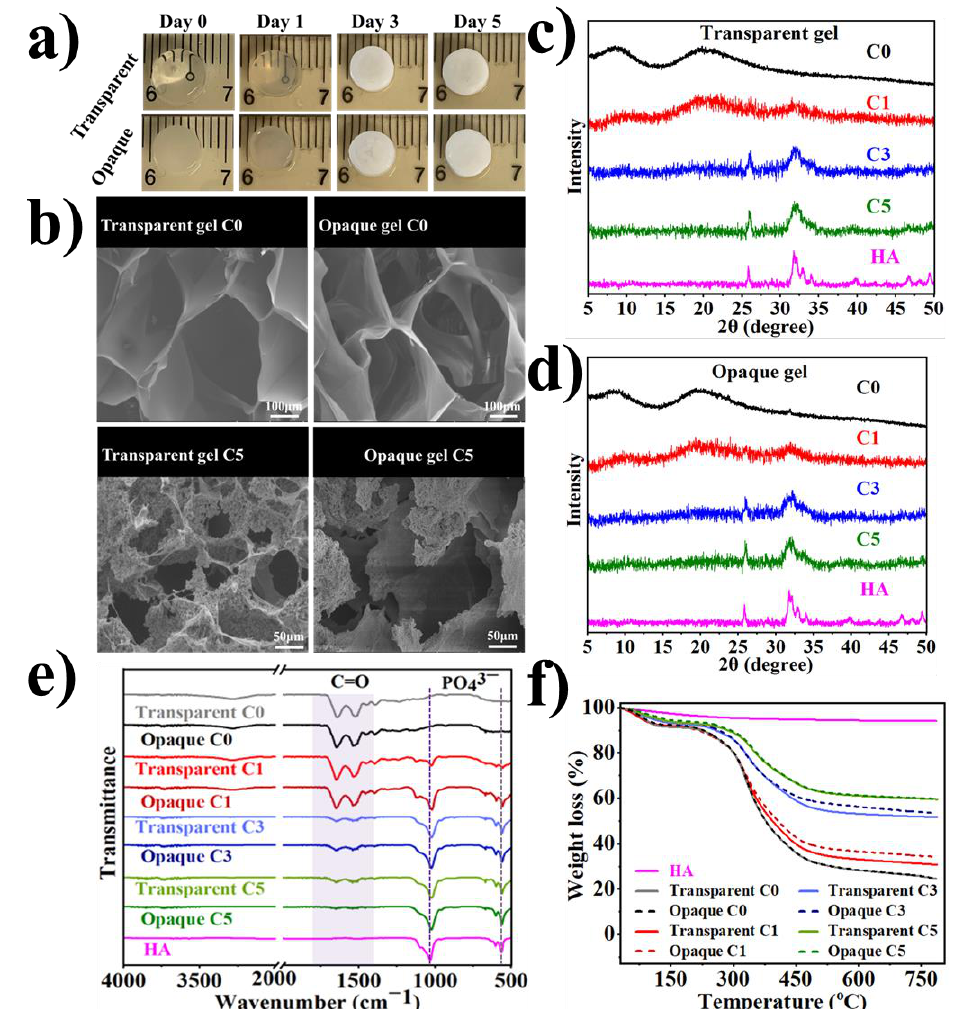
Figure 9. Bioactivity of deposition of hydroxyapatite (HA) via an alternate soaking process for BSAMA-based transparent and opaque gels. ( a ) Photographs of pristine and mineralized (1, 3, and 5 days) hydrogels and cryogels. ( b ) SEM images of pristine and mineralized hydrogels and cryogels after 5-day treatment. XRD pattern of pristine and mineralized ( c ) hydrogels and ( d ). cryogels ( e ) FTIR curves of pristine and mineralized hydrogels and cryogels. ( f ) TGA curves of pristine and mineralized hydrogels and cryogels. Commercial HA was utilized as a reference.